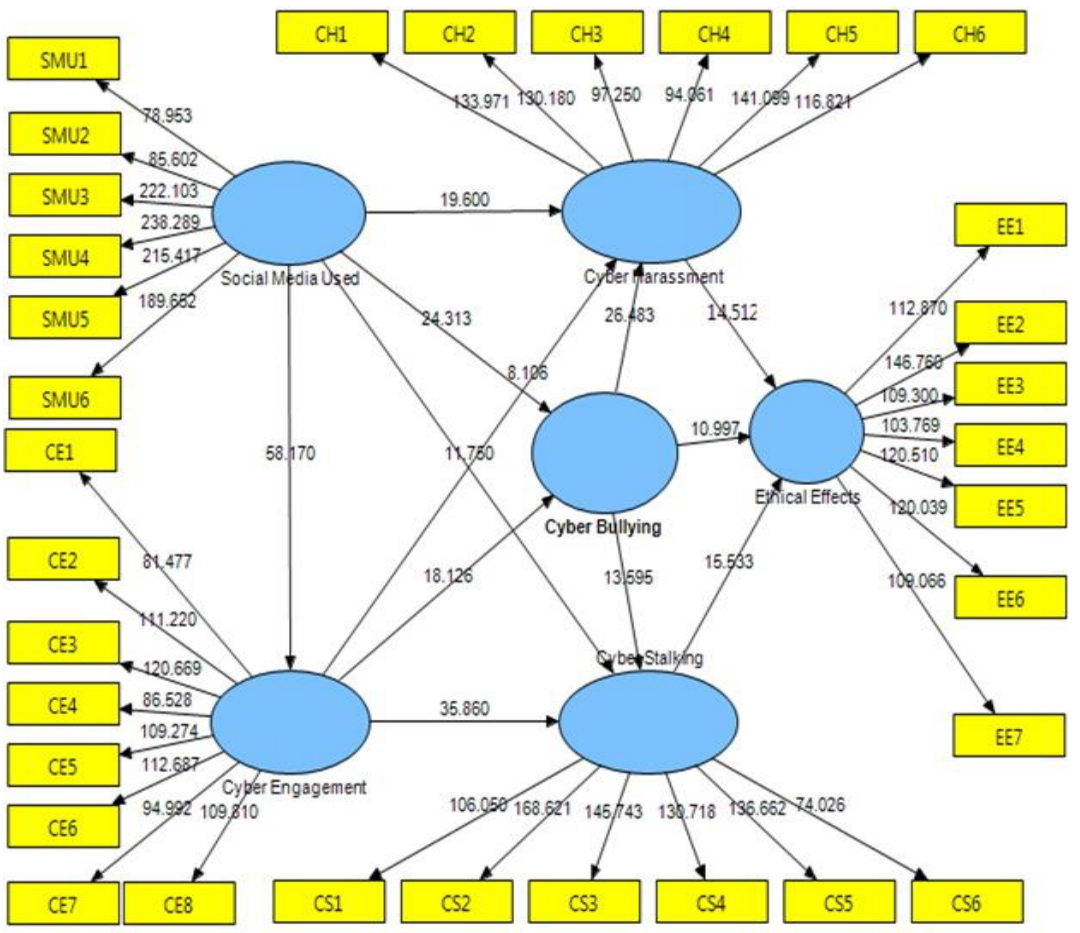
Figure 3. Path coefficients T values.